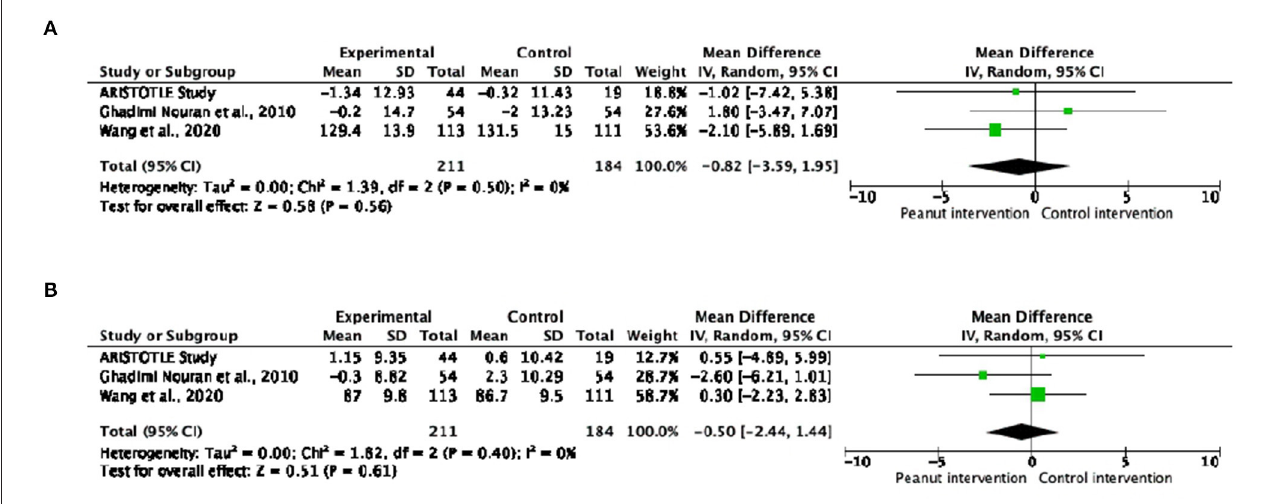
FIGURE 4 | Forest plot reporting mean differences for systolic blood pressure (A) and diastolic blood pressure (B) in relation to peanut interventions compared with control